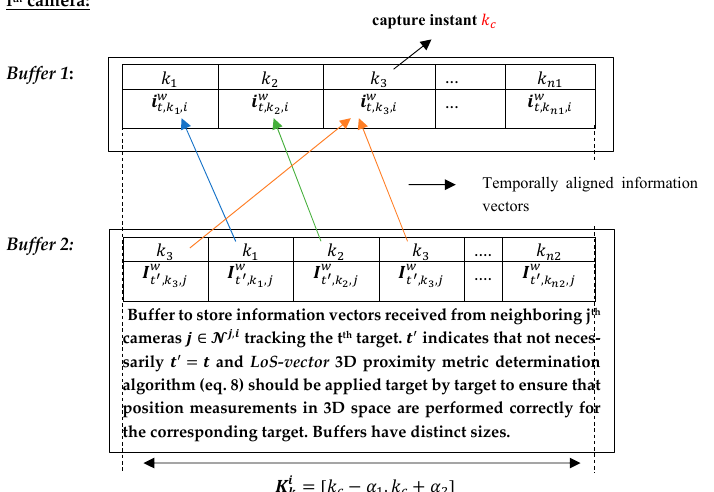
Figure 9. Buffer 1 : locally obtained information vectors stored in the i -th camera. Buffer 2 : information vectors received from neighboring cameras at different time instants within the time window period. The information vectors are temporally aligned for later 3D proximity metric computation. Reception of two or more information vectors may occur at the same time instant within the time window K i as shown at time k 3 . Colored arrows indicate temporal alignment of local information vectors with received information vectors.